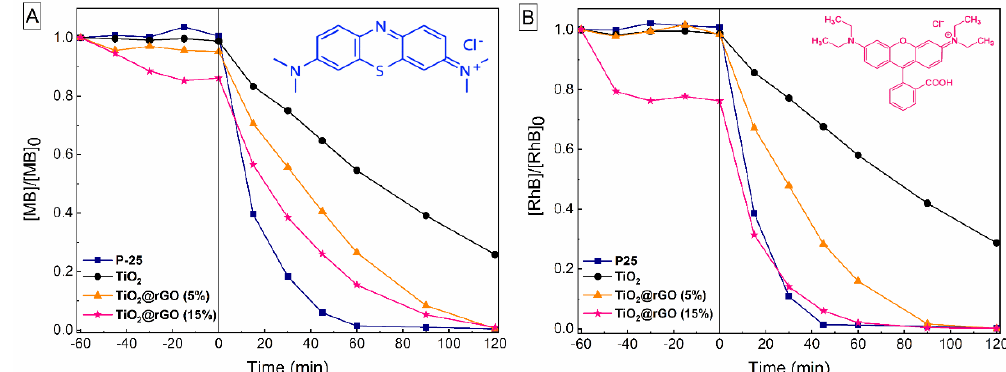
Figure 8. Photocatalytic degradation of ( A ) MB and ( B ) RhB in the dark ( − 60 min to 0 min) and under radiation (0 min to 120 min).